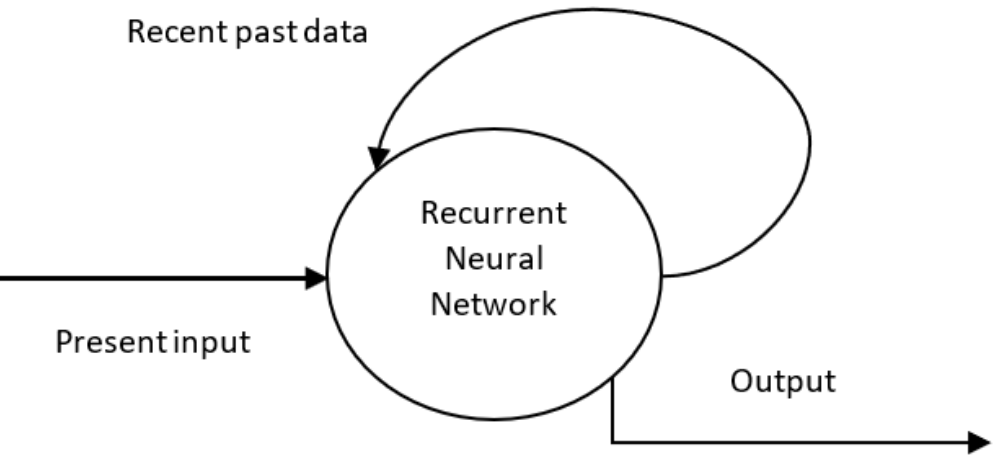
Figure 4. Recurrent neural network with memory of past output for the next prediction.